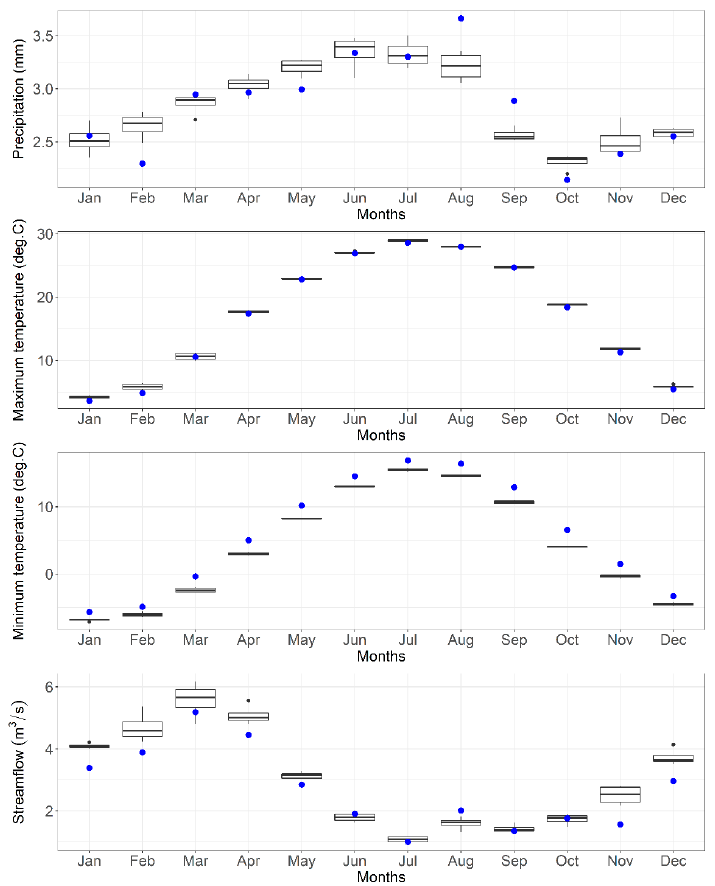
Figure A4. Comparison between monthly average of observed and GCM simulated precipitation, maximum temperature (Tmax), minimum temperature (Tmin), and streamflow for 1950–1980. The observed values are illustrated as the blue circle and the box and whisker plot represents the GCM simulated results and the range of variability between four GCMs.